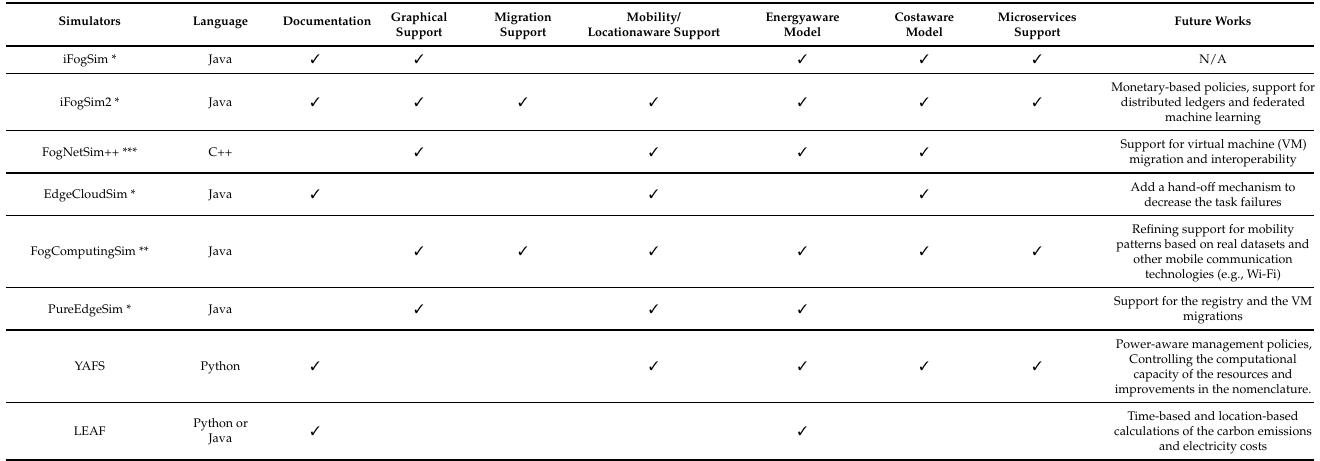
Table 3. Functional comparisons of